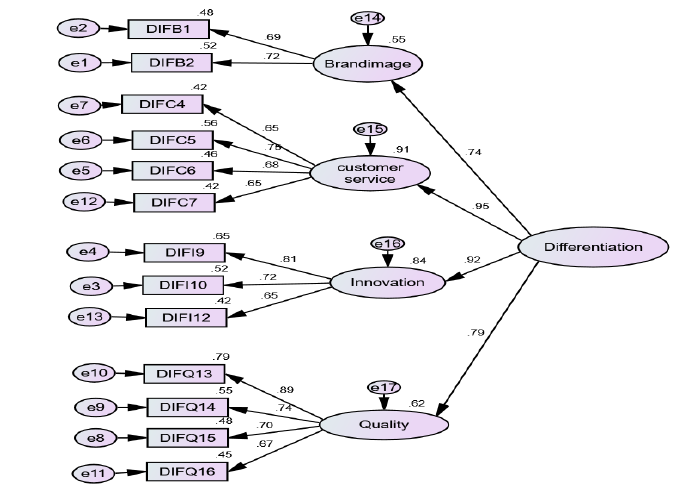
Figure 2: Differentiation strategy confirmatory factor analysis